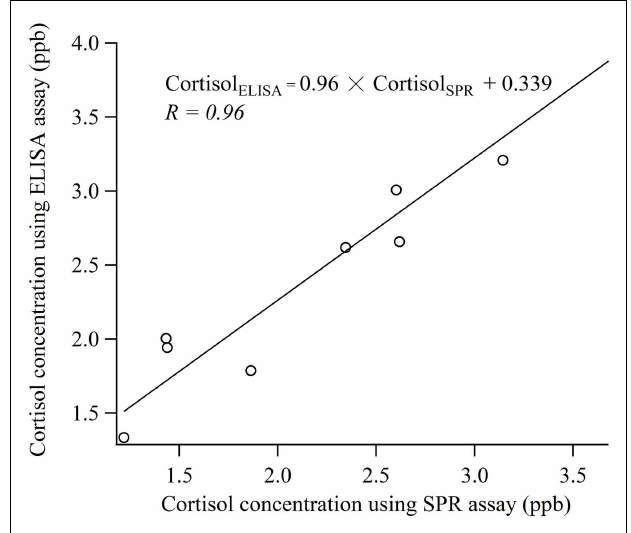
FIGURE 4 | Calculated cortisol values using the sensor and ELISA applied to cortisol standard solution .